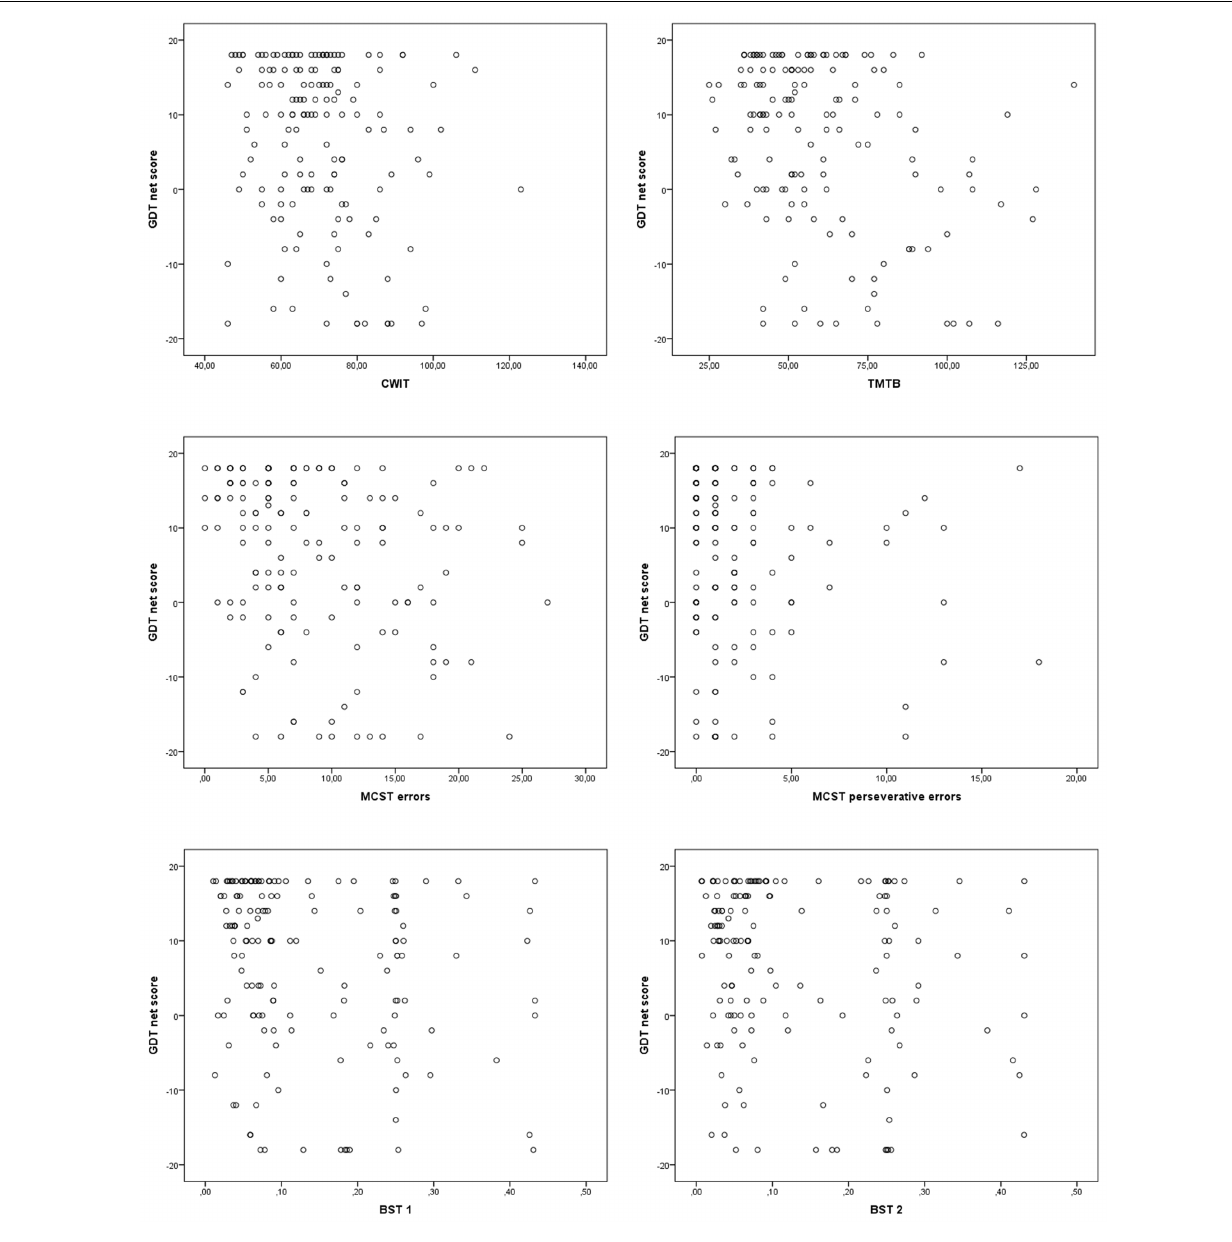
FIGURE A1 | The scatterplots between GDT net score and the scores of the executive functioning tests.